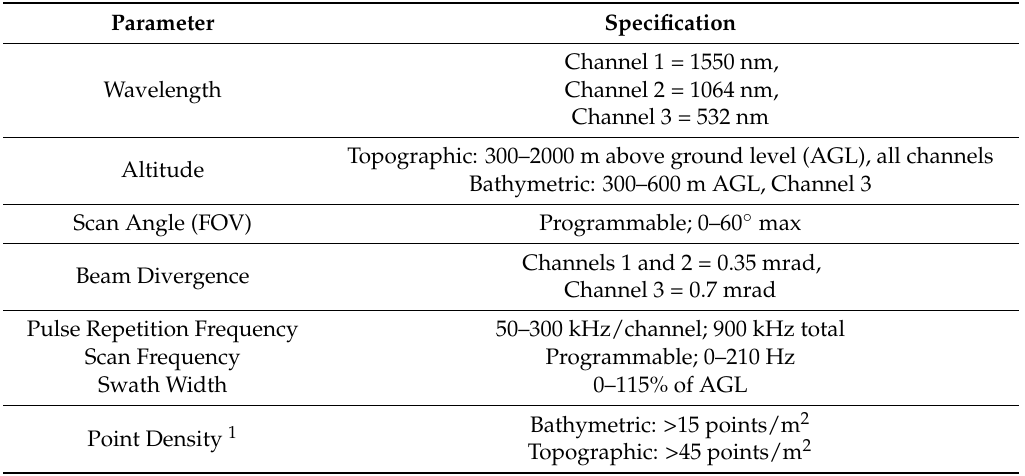
Table 1. Optech Titan sensor